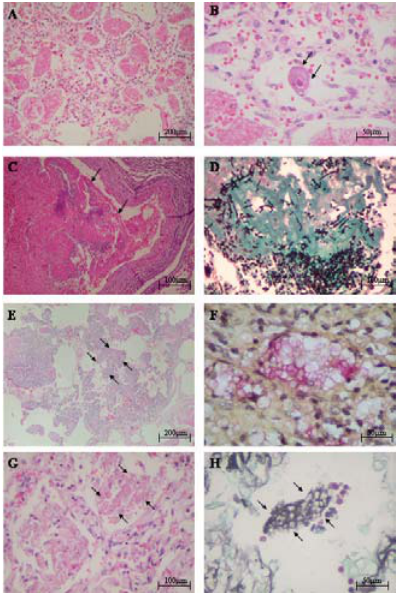
Figure 2 - Histological examination of lungs with diffuse alveolar damage show viral inclusions and fungi infection: (A) diffuse alveolar damage, showing notable amounts of viral inclusions; (B) detail of the cytomegalovirus inclusion (arrows); (C) Fungi infection represented by Aspergillus sp . (arrows); (D) detail of numerous Aspergillus sp. inside of the alveolar space (stained with silver). (E) diffuse alveolar damage, showing the presences of Cryptococcus sp . (arrows); (F) detail of this fungi stained with mucicarmine; (G) Diffuse alveolar damage, showing infection by Pneumocystis carinii inside the alveolar space; (F) detail of Pneumocystis carinii (arrows) (stained with silver). Hematoxylin & eosin X 200 (panels A, E), X 100 (panels C, G), and X 50 (panel B); Silver stain X 100 (panel D), and X 50 (panel H); Mucicarmine stain X 50 (panel